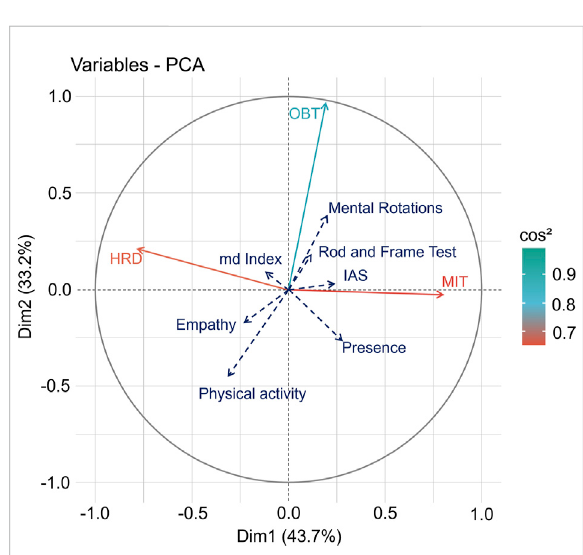
FIGURE 5 Principal Component Analysis with the two main dimensions projected on orthogonal axes. OBT, MIT, and HRD represent the mean response time performances in the own-body transformation task (expressed as Pre-Post/Pre), the difference between perceived self-location before and after the illusion, and the heart rate deceleration following the threatening stimulus, respectively. Other measures (individual dispositions) are represented as supplementary